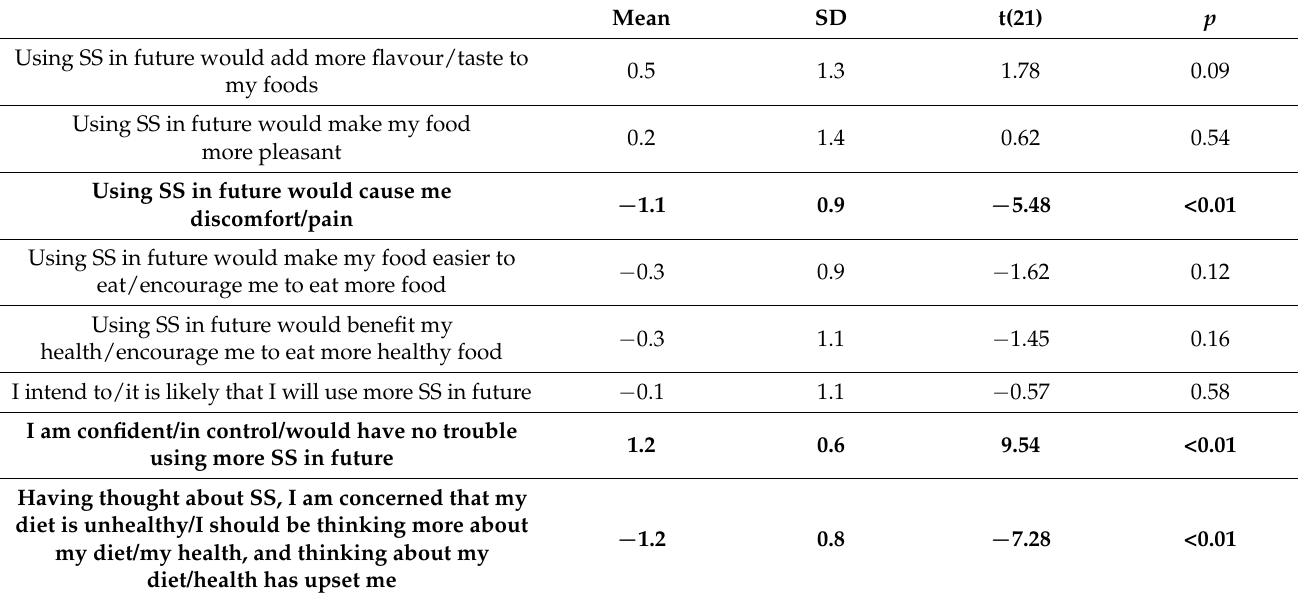
Table 4. Mean, SD score from − 2 to +2 for all attitudinal statements in the questionnaire on future sauce and seasoning use, in the sample as a whole ( N = 22). Statistics (t values) demonstrate a difference from 0 (no